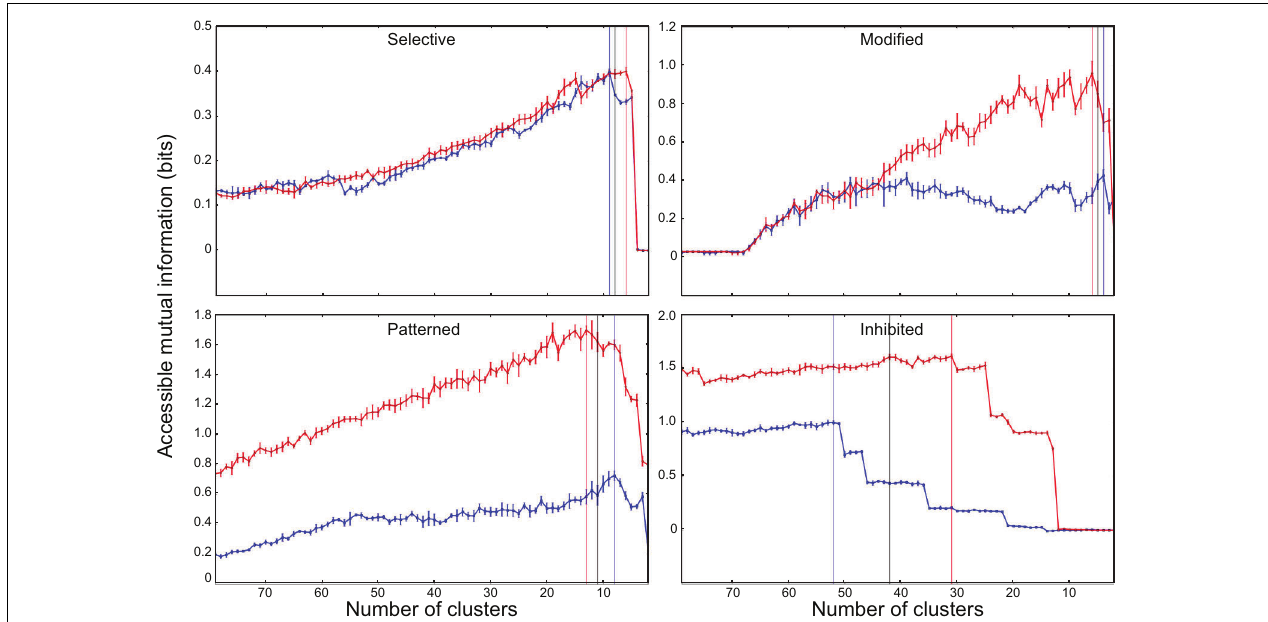
FIGURE 1 | Application of the clustering mutual information protocol to exemplars fromthefourneuronclasses(seesection3). Numberofclusters are shown on the horizontal axis (with high numbers, implying more information,shownontheleft). Accessible mutualinformationisplottedonthe vertical axis. Typical neurons were selected from classes (1) selective ; (2) modified ; (3) patterned ; and (4) inhibited . This analysis returns two important